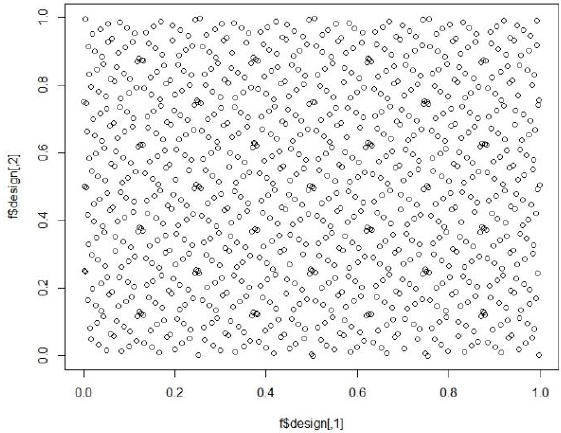
Figure 6. Quasi-random distribution.